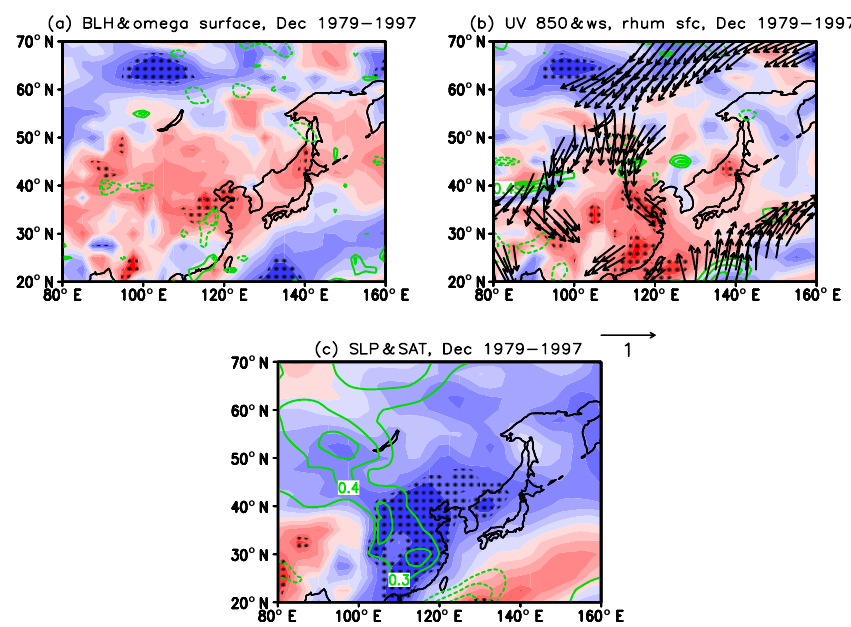
Figure 8. The CC between the SC ES and (a) BLH (shading) and surface omega (contour), (b) wind at 850hPa (arrow), surface wind speed (shading), and surface relative humidity (contour), and (c) SLP (contour) and SAT (shading) in December from 1979 to 1997. The black dots indicate the CC exceeded the 95% confidence level ( t test). The linear trend is removed.